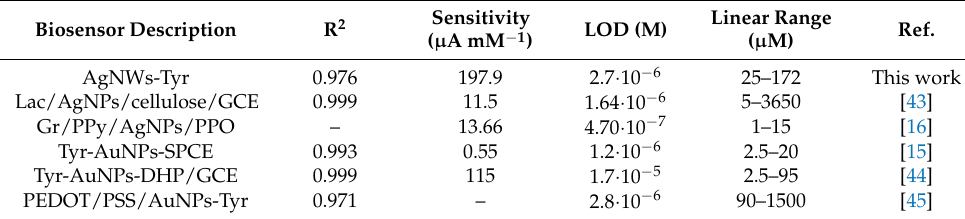
Figure 7. ( a ) Differential pulse voltammetry (DPV) response in 0.01 mol·L − 1 PBS, pH 7.0 to an increase concentration of catechol of an ITO-AgNWs–Tyr, ( b ) calibration curve of the response for increasing concentration of catechol.